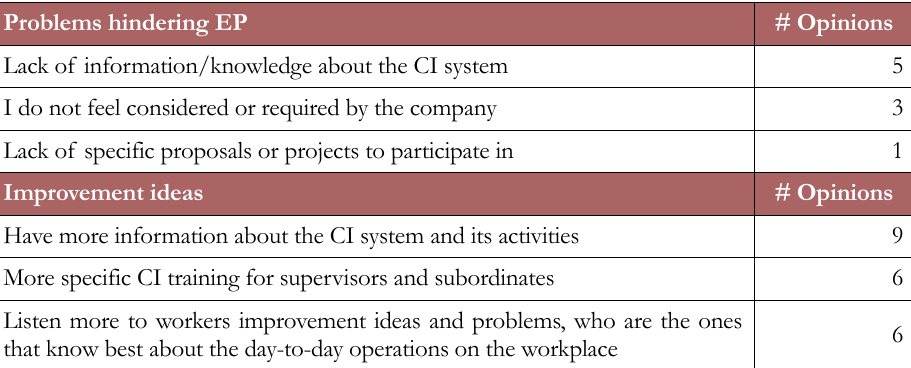
Table 2. Service case: Top 3 improvement ideas and problems hindering